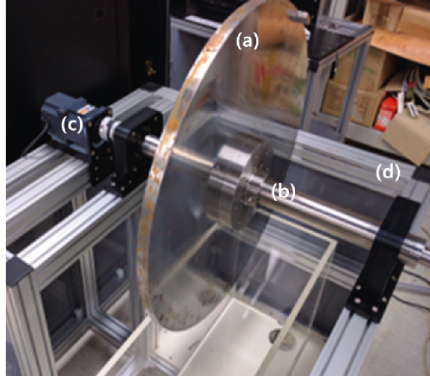
Figure 8: Photograph of dynamo-meta module: (a) specimen, (b) shaft, (c) BLDC motor, and (d) frame.